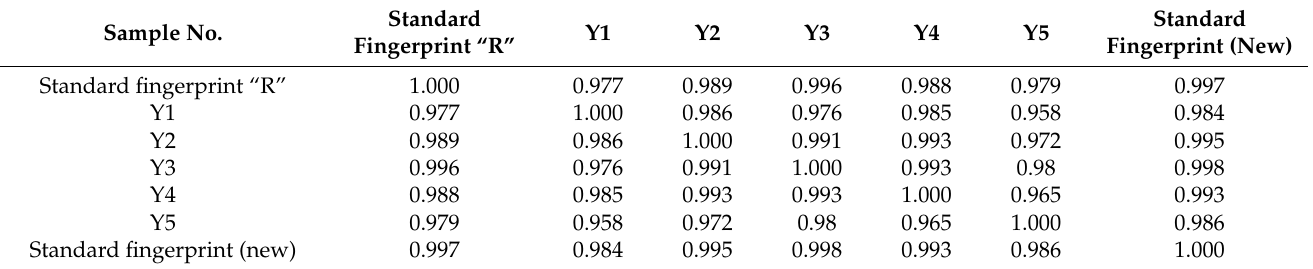
Table 2. Similarity of fingerprints of 5 batches of commercially available Echinacea pupurea (L.) Moench samples from different origins.